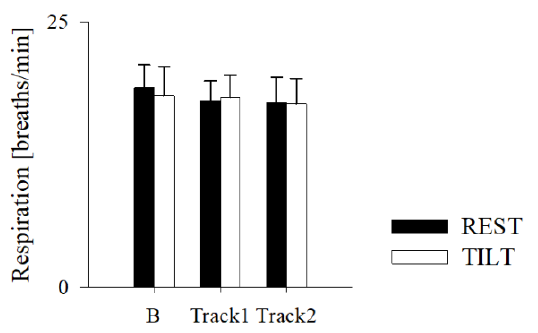
Figure 4. Results of the respiratory rate estimation in the healthy subjects while supine (REST) and during 70° head-up tilt test (TILT) in normal condition (B) and while listening to Track1 (activating algorithmic music) and Track2 (relaxing algorithmic music). Data are expressed as mean ± standard deviation.